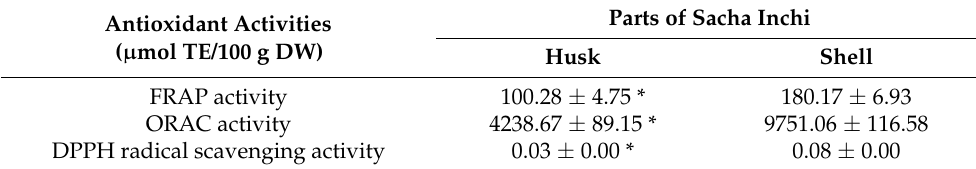
Table 5. Antioxidant activities in the husk and shell of sacha inchi.